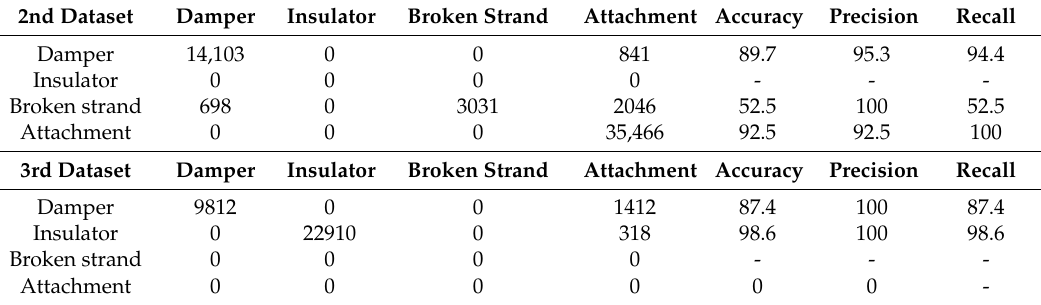
Table 6. Object recognition at point cloud level in SPL partition (in